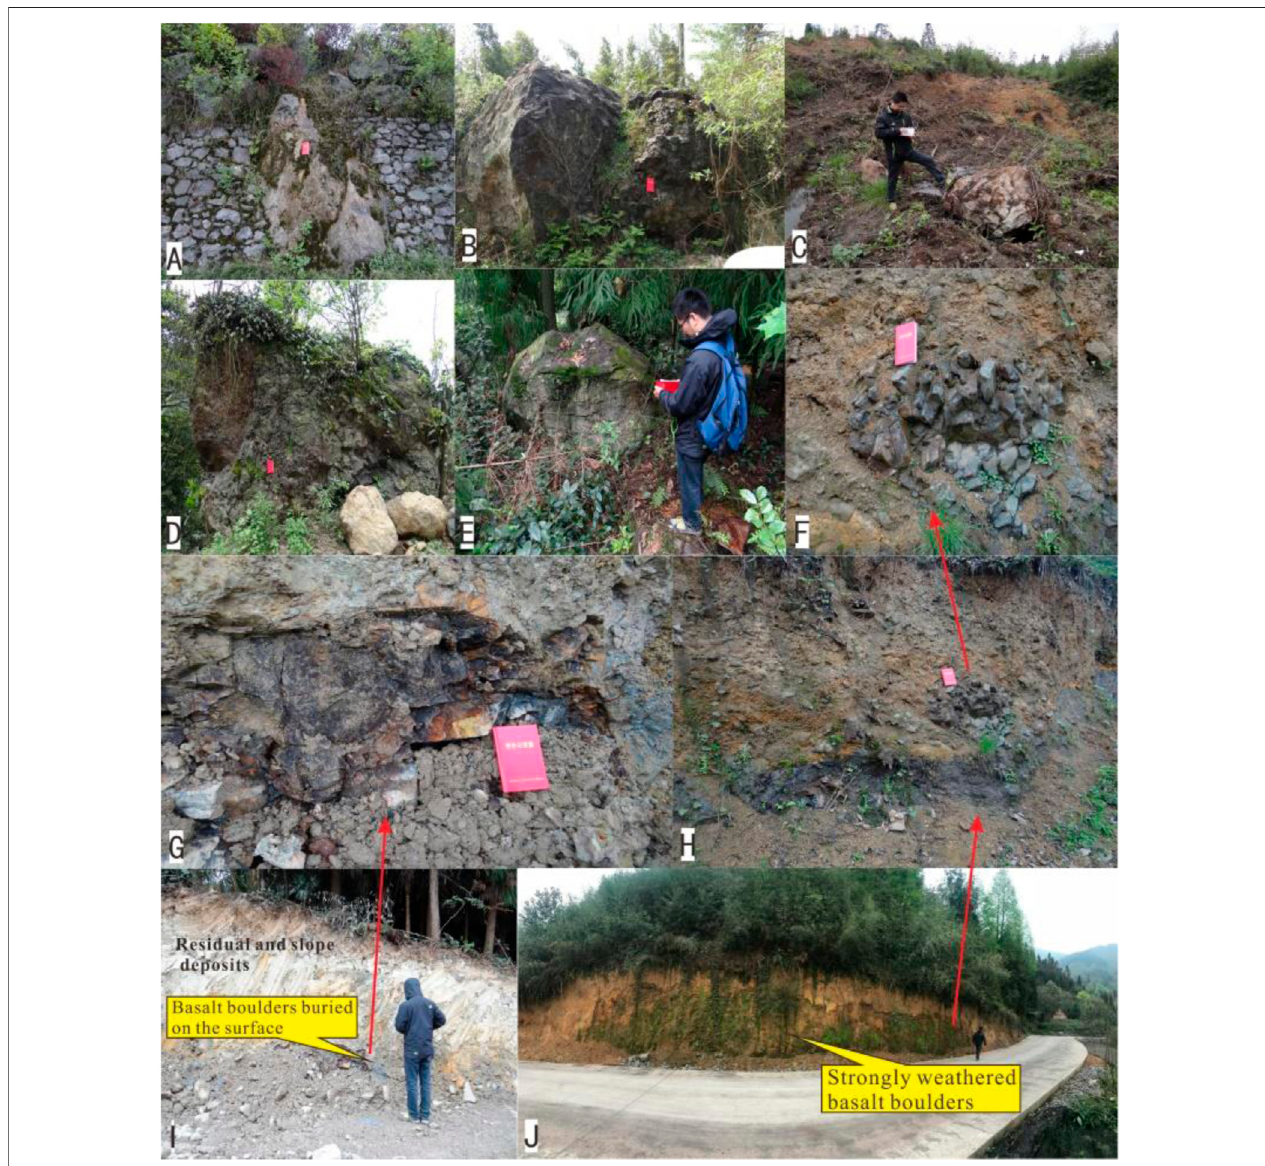
FIGURE 6 | Basalt boulders widely distributed in the landslide transportation area. (A,B,C,D,E) Basalt boulders distributed at observation points D060, D041, D034, D033, and D016, respectively. (G,I) Basalt boulders buried on the surface can be seen at observation point D035 (seriously weathered and show severe argillization). (F,H,J) Massive basalt boulders and gravels exposed at the observation point D036.